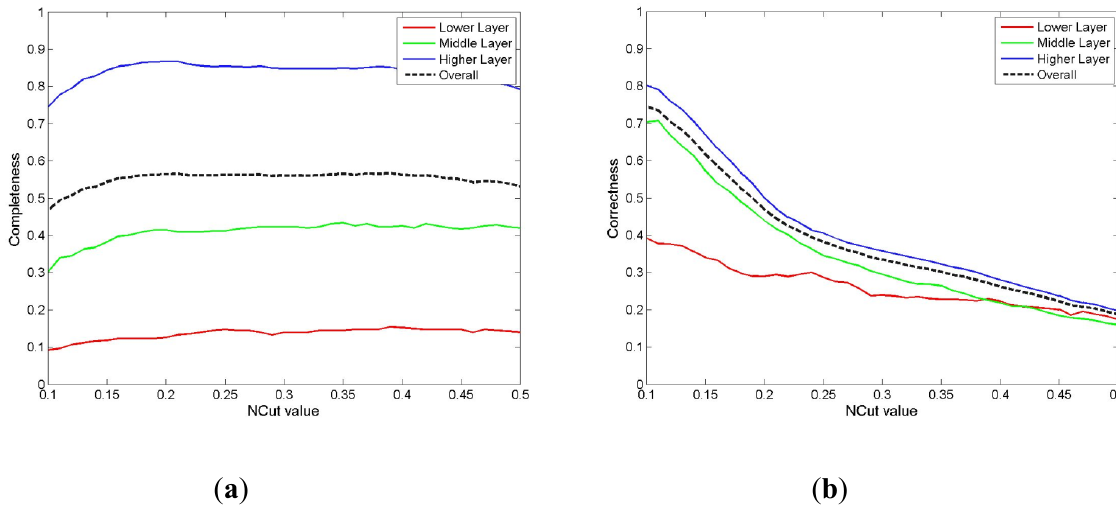
V for the dataset of Test Site I Size